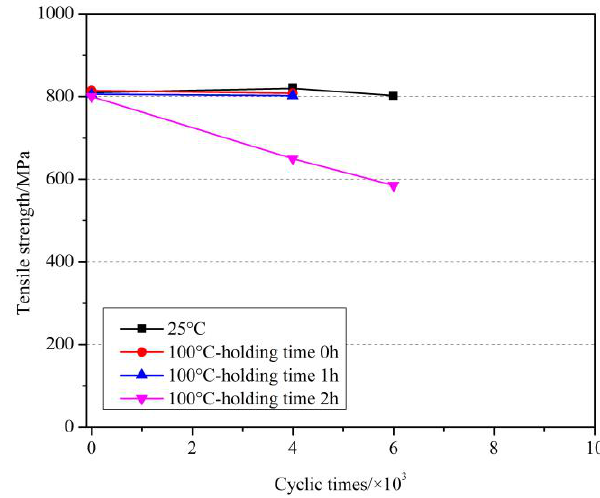
Figure 9. The effect of cyclic load on the tensile strength of GFRP bars at 100 °C.